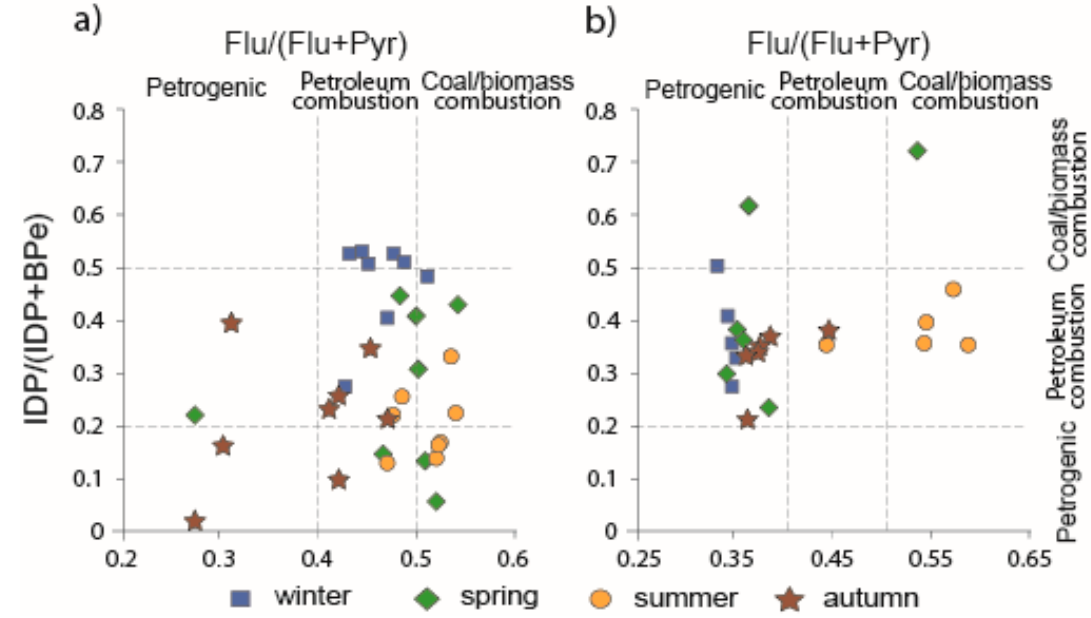
Figure 4. PAHs diagnostic ratios in the surface water of the Partizanskaya River Estuary ( a ) and the Tumen River Estuary ( b ). Tumen River Estuary ( b